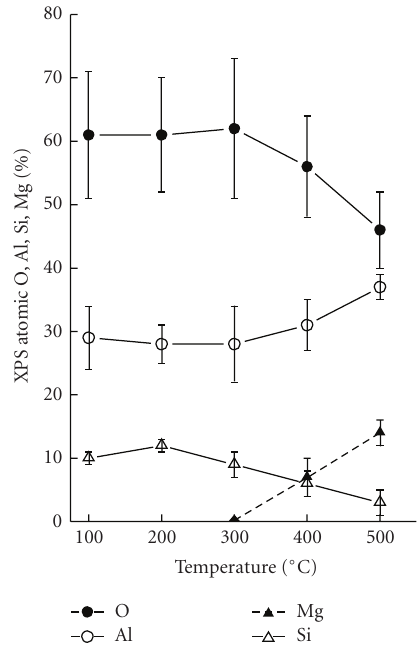
Figure 1: Evolution of composition with temperature for the untreated A361 surface.